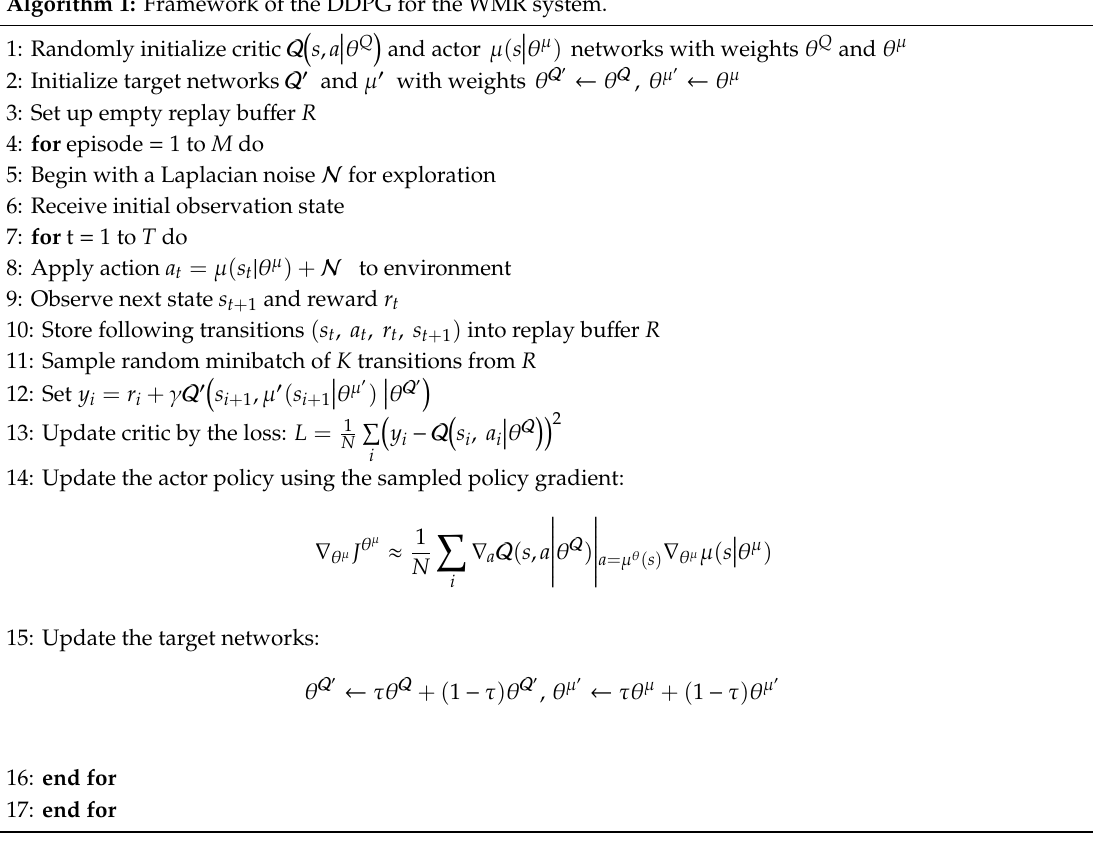
Figure 5. Illustration of an actor-network critic-network.